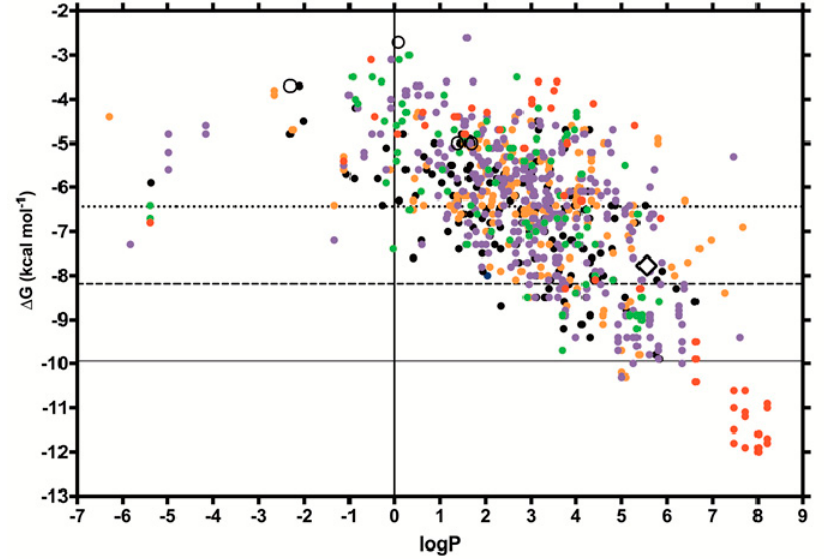
Figure 2. The results of the rigid docking of 889 pesticide molecules to BLG (1GXA). The calculated logP of each molecule is plotted versus the binding energy found through docking. A solid vertical line indicates the logP value where a compound is equally soluble in water and in octanol. The horizontal lines indicate the mean affinity (dotted line at − 6.4 kcal/mol), and two standard deviations: − 1 σ (broken line at 8.1 kcal/mol) and − 2 σ (solid line at − 9.94 kcal/mol). The pesticide class Ia is in red, class Ib in green, class II in purple, class III in orange and class U in black. The palmitate docking result is shown with a diamond, and the negative controls are in empty circles.